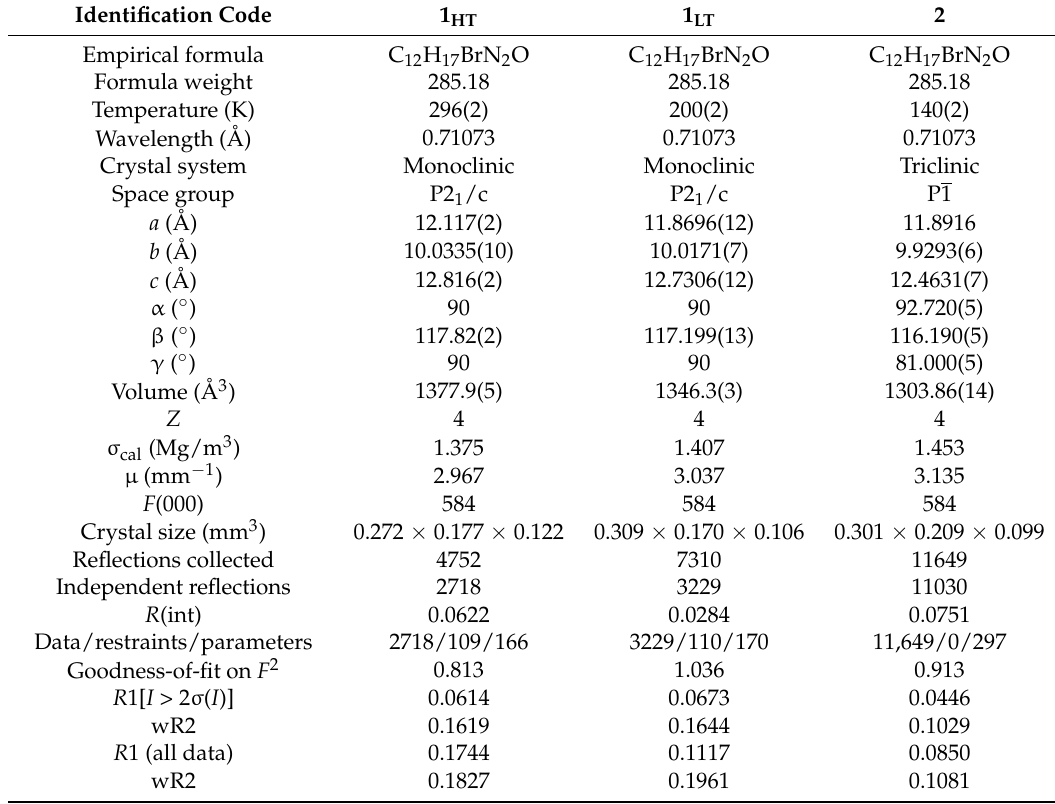
Table 1. Experimental and structure refinement